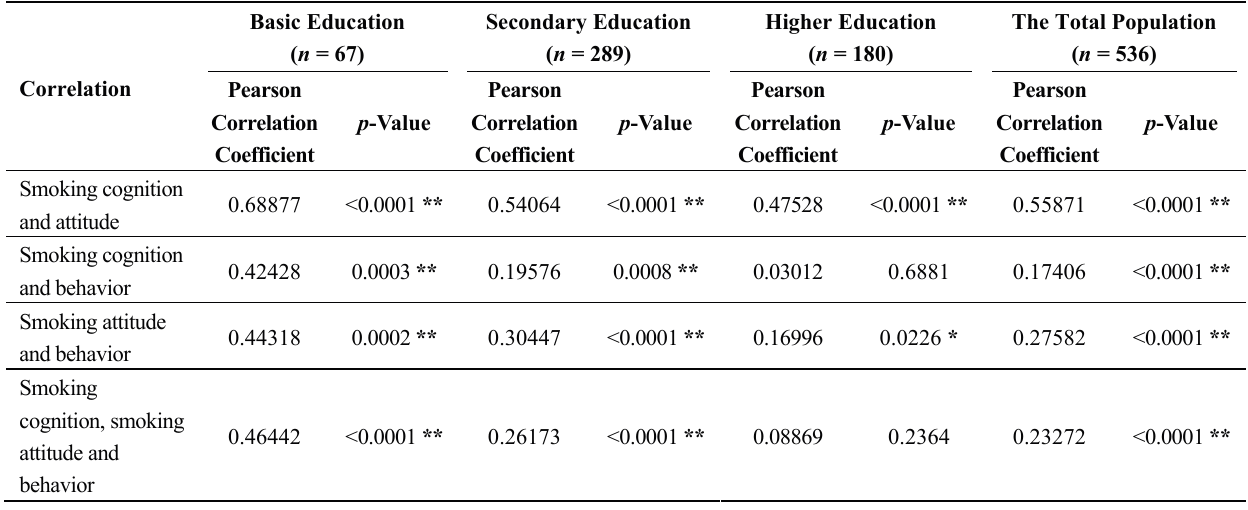
Table 5. The correlation analysis of knowledge, attitude and behaviors, Chongqing, China,